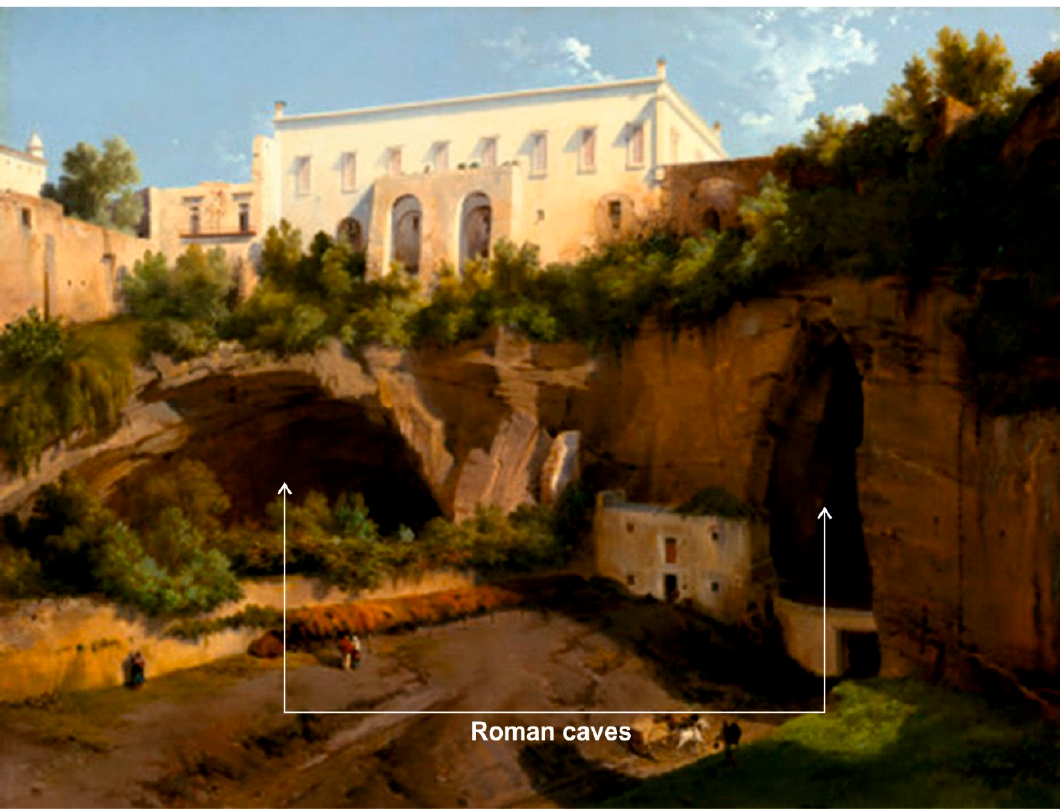
Figure 9. The painting by Lancelot-Théodore Turpin de Crissé “View of a Villa, Pizzofalcone, Naples” (1819), National Gallery of Art, New York .